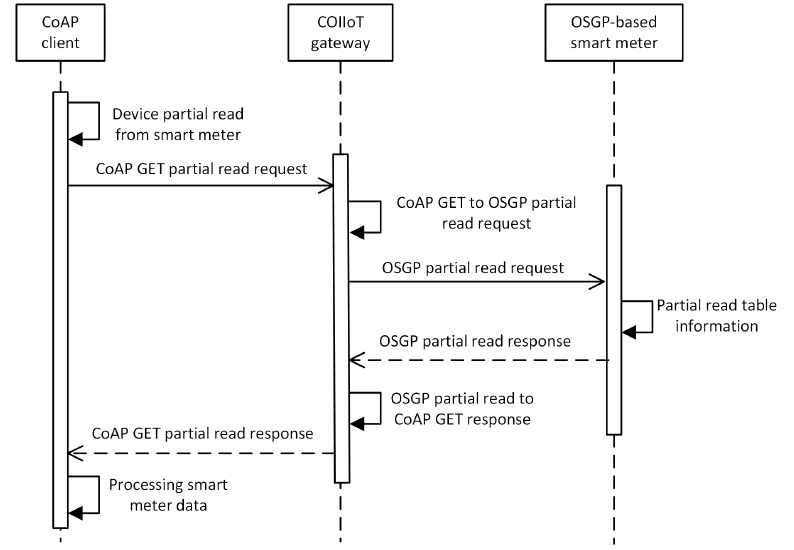
Figure 7. Sequence diagram for a partial read from the smart